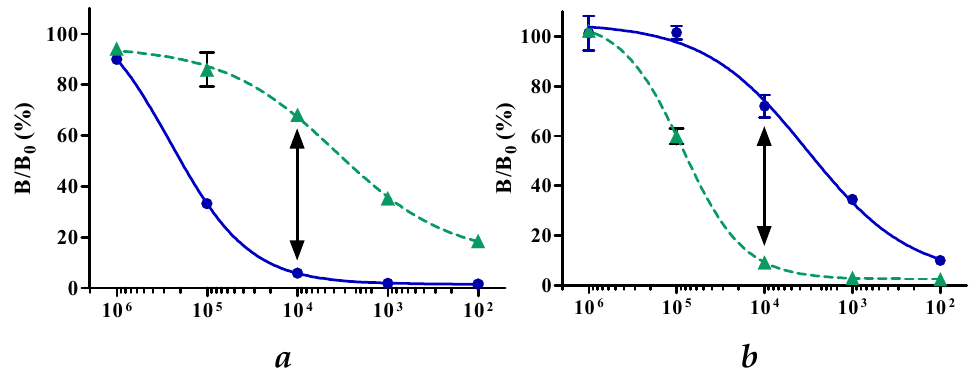
Figure 4. Absolute responses (B/B 0 (%)) for A1A1 milk ( ● ) and A2A2 milk ( ▲ ) in 10-fold dilution series, in the β CA1 assay ( a ) and the β CA2 assay ( b ). The dilution generating the largest B/B 0 (%) difference between the A1A1 and A2A2 milk in both assays is indicated by the double-headed ar- row.